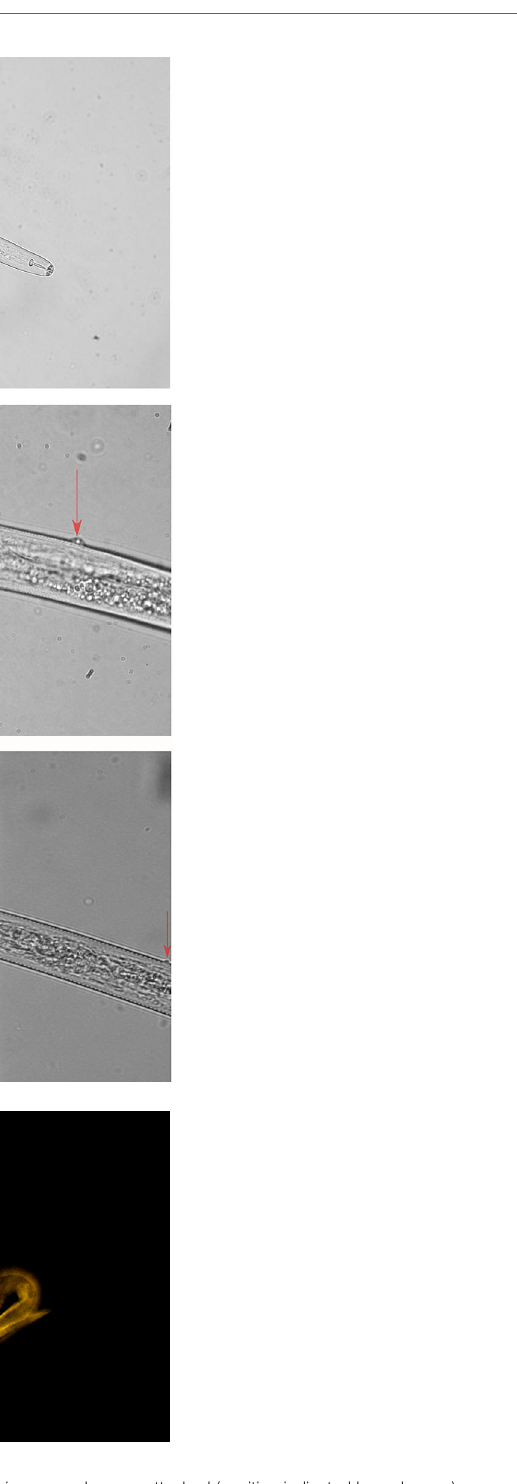
FIGURE 6 | (A) 400x magni fi cation Pratylenchus spp. recovered from ESFN soil with Pasteuria spp. endospore attached (position indicated by red arrow). (B) 1000x magni fi cation of Pratylenchus spp. recovered from ESFN soil with Pasteuria spp. endospore attached (position indicated by red arrow). (C) 1000x magni fi cation of free living non-parasitic nematode recovered from ESFN soil with several Pasteuria spp. endospores attached (positions indicated by red arrows). (D) 1000x magni fi cation of fl uorescence image of Pratylenchus spp. recovered from ESFN soil with Pasteuria spp. endospore attached (position indicated by blue arrow), showing anti- Pasteuria penetrans antibody